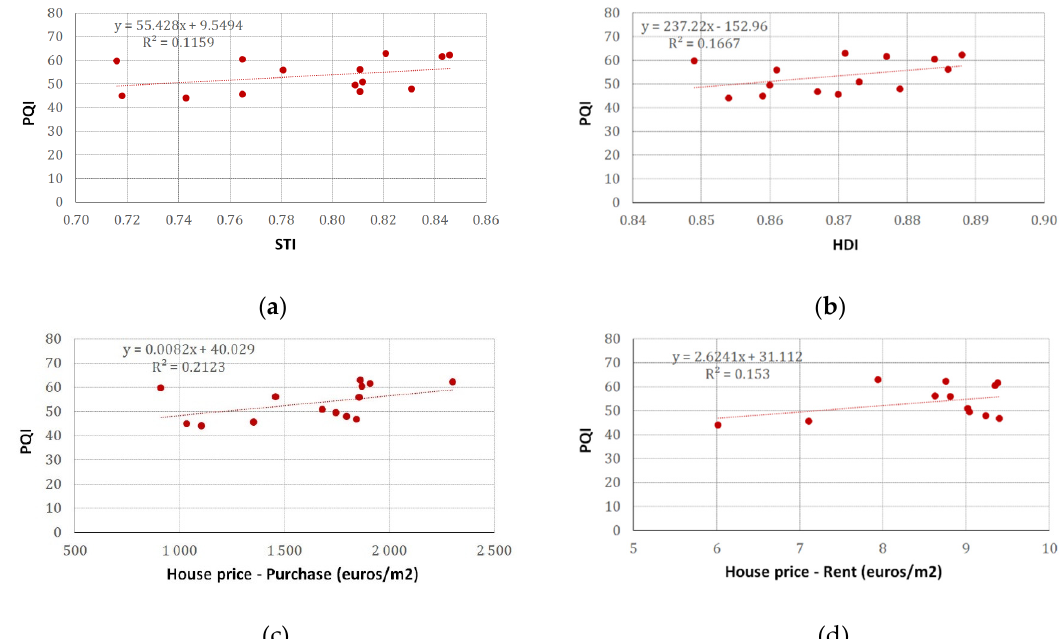
Figure 7. Correlation between the quality of the parks (PQI) and the socio-demographic variables of the population living within 300 m of the nearest park: ( a ) study level index for the population; ( b ) average value of HDI; ( c ) Average value of the purchasing price (euros/m 2 ) and ( d ) average value of the rental price (euros/m 2 ). Source: own work.